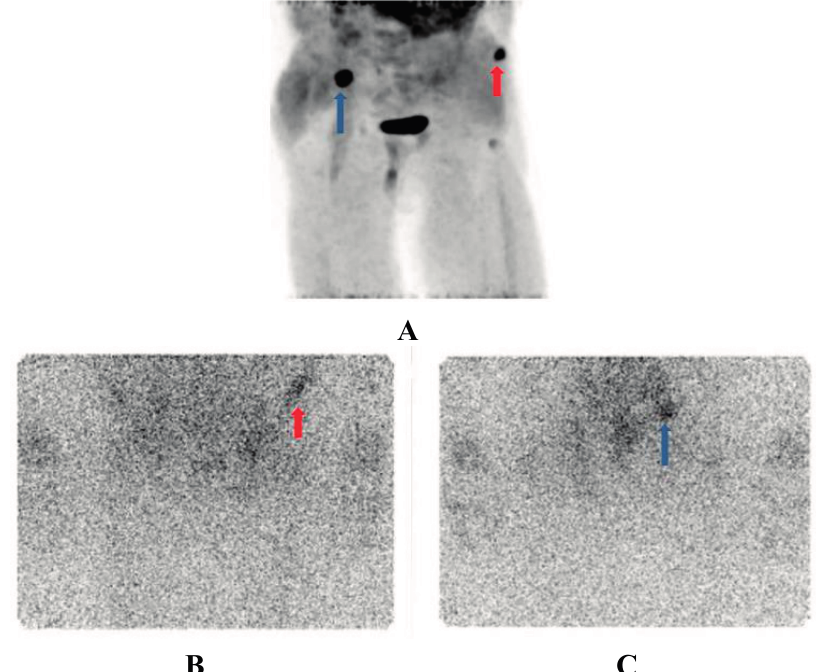
Figure 4. Diagnostic imaging with F-18-fluorocholine-PET; MIP-image (3-D-presentation); Strong uptakes in the right iliac crest (blue arrow) and left anterior ileal wing (red arrow) ( A ). Same lesion imaged at 7 days after 223 RaCl 2 therapeutic dose using gamma camera, the left anterior ileal wing (red arrow) lesion is better seen in the AP-view ( B ), whereas the lesion in the right iliac crest (blue arrow) is better seen in the AP-view ( C ).